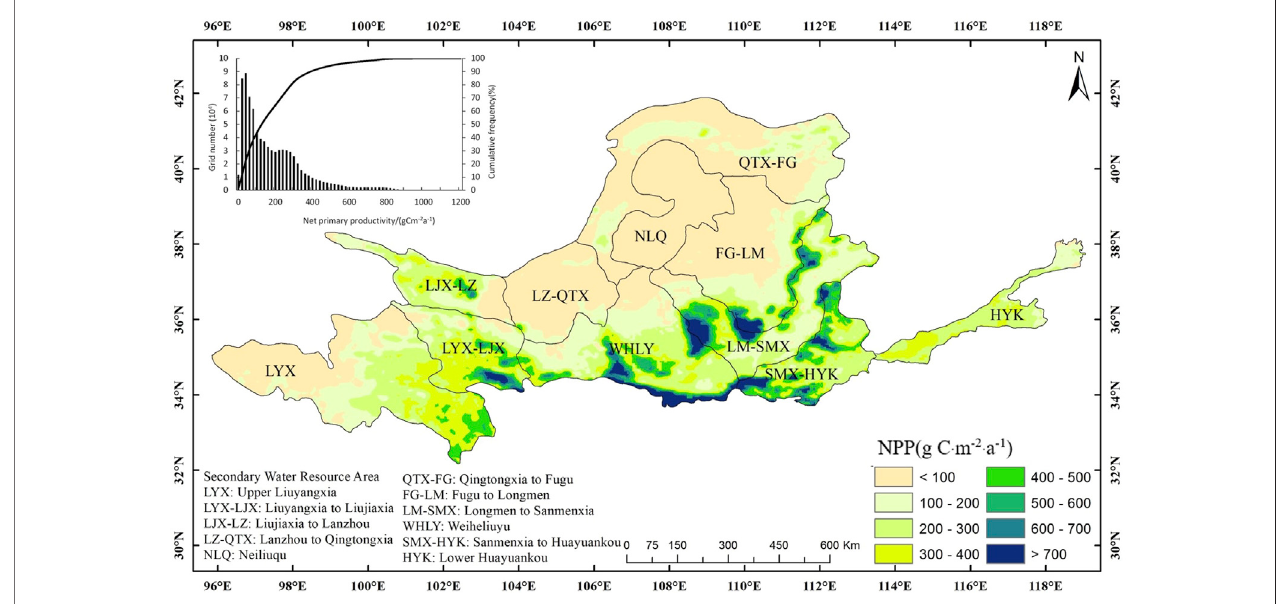
FIGURE 4 | Spatial distribution of net primary productivity (NPP) during 1981 and 2020.